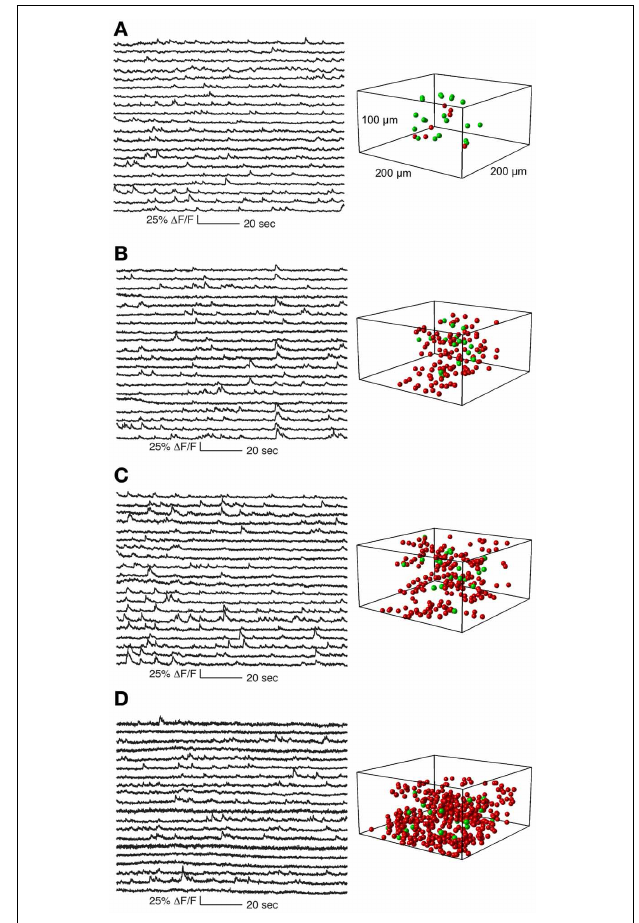
FIGURE 5 | Functional calcium signals recorded during spontaneous activity from data sets with different number of simultaneously recorded cells. All data sets were collected from nearby sites. Locations of cells whose traces are shown on the left panel are labeled green on the right panel. Remaining cells recorded but whose traces are not shown are labeled red. The population sizes are: (A) 27 cells (at 1.8 Khz sampling for each cell), (B) 133 cells (375Hz), (C) 205 cells (244Hz), and (D) 411 cells (122Hz). Functional traces are downsampled to 20Hz for visualization and comparison. All traces from these datasets are shown in Supplementary Figures